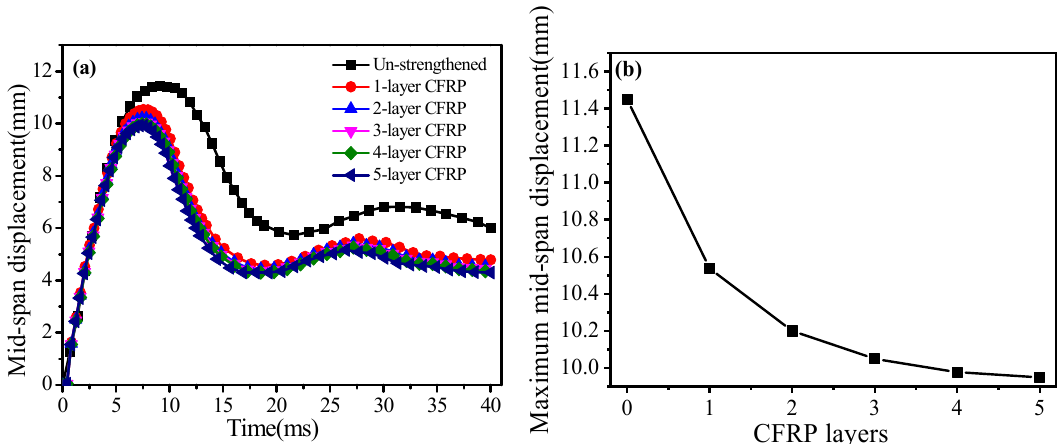
Figure 16. ( a ) Mid-span displacement-time histories and ( b ) maximum displacements of T-beams strengthened with different CFRP strengthening layers.